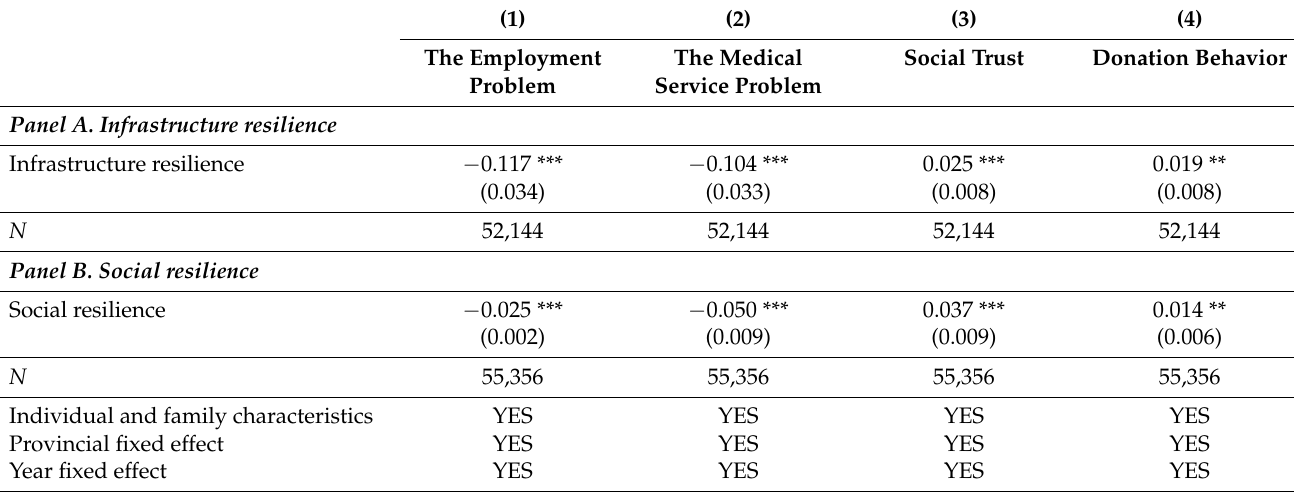
Table 11. The increase of social integration and social